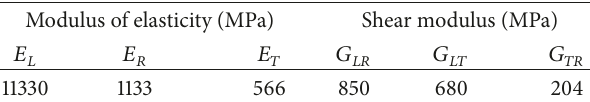
Table 2: : Material parameters of column.